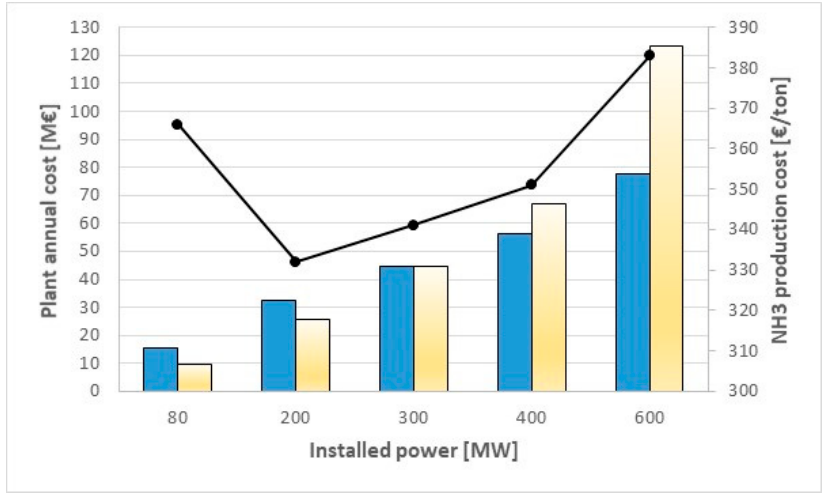
Figure 5. Ammonia specific cost and annual costs (variable and fixed) vs. plant size.